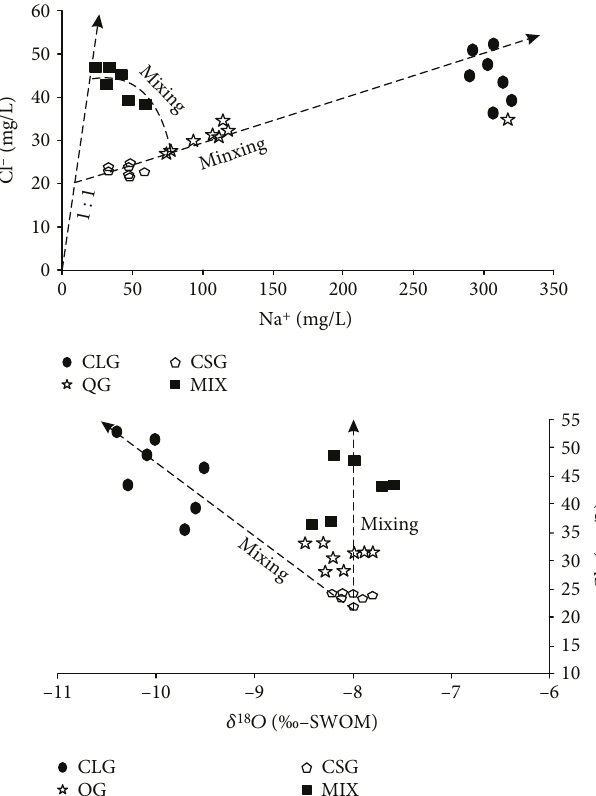
Figure 3: Na + /Cl − and Cl- δ 18 O diagrams of the water samples. MIX: mixing water; CLG: Cambrian aquifer groundwater; QG: Quaternary aquifer groundwater; sw: surface water; CSG: coal-bearing sandstone aquifer